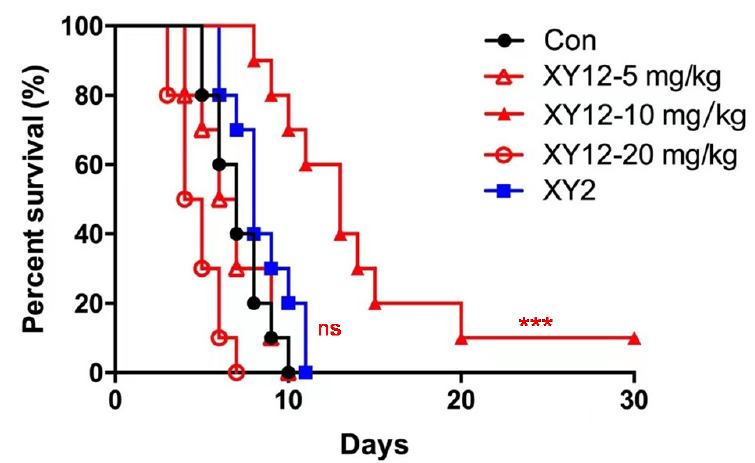
Figure 4. Survival of mice infected with C. albicans systemically. Female ICR mice were infected with C. albicans 1.5 × 10 6 CFU through tail vein; 10 mg/kg of XY2 or 5, 10, 20 mg/kg of XY12 was injected intraperitoneally once a day for 5 days and the survival of mice was observed for 30 days. Log-rank (Mantel–Cox) test, *** p < 0.001, ns—no significance.